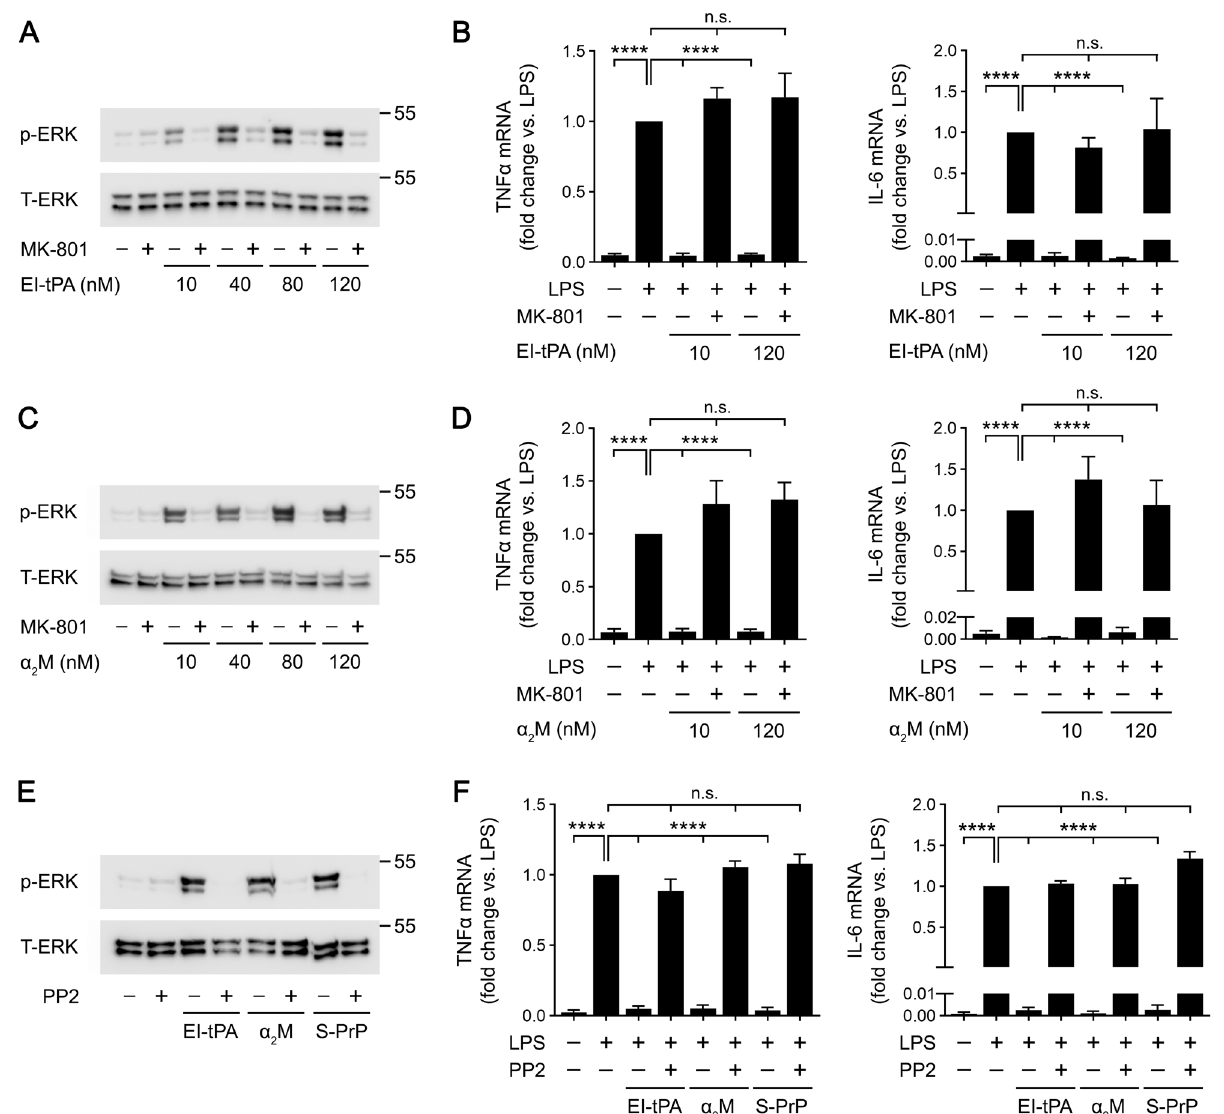
Figure 2. The NMDA-R and SFKs are important mediators of EI-tPA, α 2 M and S-PrP cell-signaling in macrophages. ( A ) BMDMs were pretreated with MK801 (1.0 µM), or vehicle for 30 min, and then stimulated for 1 h with increasing concentrations of EI-tPA (10–120 nM). Cell extracts were subjected to immunoblot analysis to detect phospho-ERK1/2 and total ERK1/2. (B) BMDMs were pretreated with MK801 (1.0 µM), or vehicle for 30 min then treated with LPS (0.1 μg/mL), LPS plus El-tPA (12 nM), LPS plus El-tPA (120 nM), or vehicle for 6 h. RT-qPCR was performed to compare mRNA levels for TNFα and IL-6 (n = 4–6). (C) BMDMs were pretreated with MK801 (1.0 µM), or vehicle for 30 min, and then stimulated for 1 h with increasing concentrations of α 2 M (10–120 nM). Cell extracts were subjected to immunoblot analysis to detect phospho- ERK1/2 and total ERK1/2. (D) BMDMs were pretreated with MK801 (1.0 µM), or vehicle for 30 min then treated with LPS (0.1 μg/mL), α 2 M (10 nM), LPS plus α 2 M, or vehicle for 6 h. RT-qPCR was performed to compare mRNA levels for TNFα and IL-6 (n = 4–5). (E) BMDMs were pretreated with PP2 (1.0 µM), or vehicle for 2 h, and then stimulated for 1 h with EI-tPA (10 nM), α 2 M (10 nM), S-PrP (40 nM) or vehicle. Cell extracts were subjected to immunoblot analysis to detect phospho-ERK1/2 and total ERK1/2. (F) BMDMs were pretreated with PP2 (1.0 µM) or vehicle for 2 h, and then with LPS (0.1 µg/ml) plus EI-tPA (10 nM), α 2 M (10 nM), S-PrP (40 nM), or vehicle for 6 h. RT-qPCR was performed to compare mRNA levels for TNFα and IL-6 (n = 4–5). Data are expressed as the mean ± SEM (One-way ANOVA; **** P < 0.0001, n.s.: not statistically